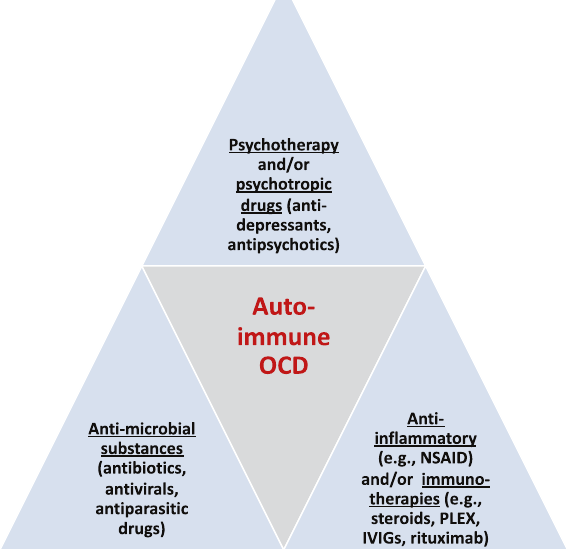
Fig. 3 The three main components in the treatment of auto- immune obsessive-compulsive disorders (cf. [71, 73, 134 – 136]). Abbreviations: OCD, obsessive-compulsive disorder; IVIGs, intrave- nous immunoglobulins; NSAID, non-steroidal anti-in fl ammatory drug; PLEX,